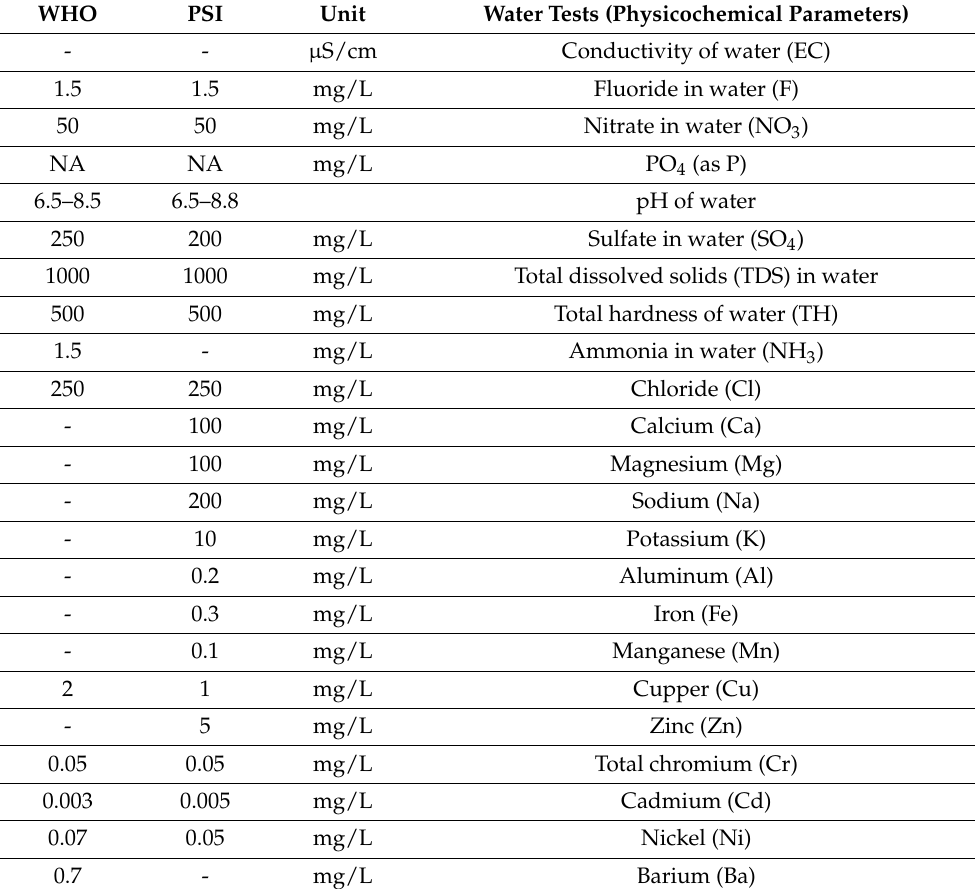
Table 1. The Palestinian national standards (PSI) and World Health Organization (WHO) permissible limits for water